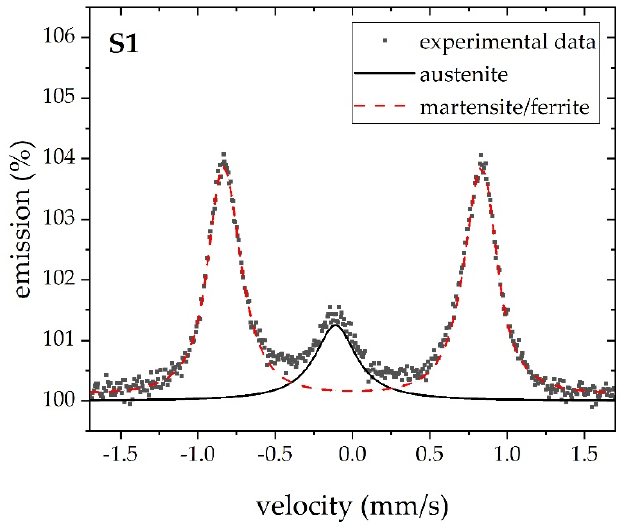
Figure 5. High-resolution Mössbauer spectrum recorded at a low-velocity interval of central part for sample S1.